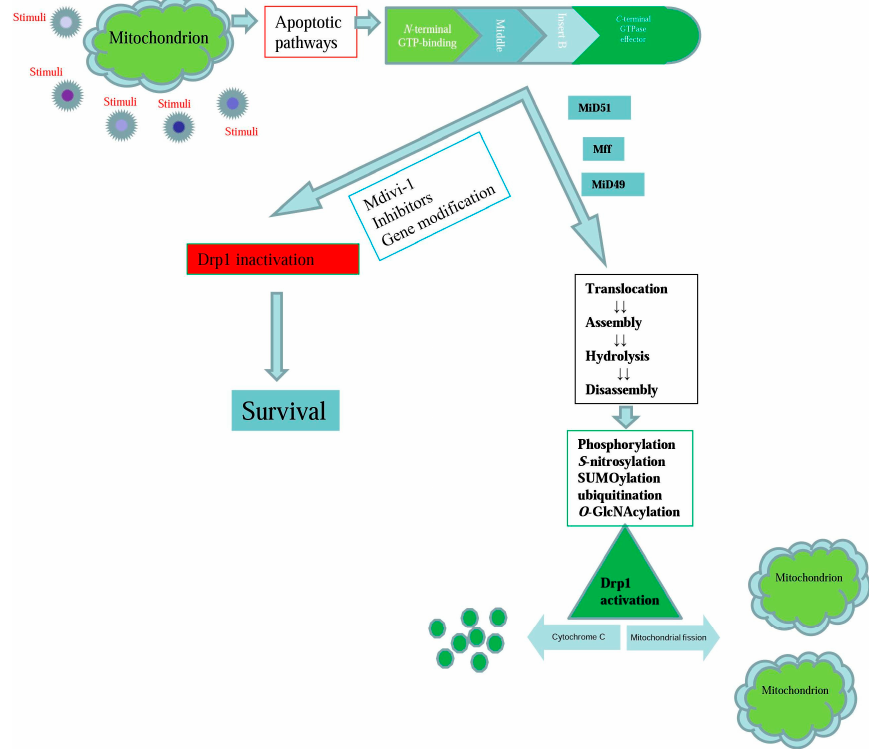
Figure 1. Various stress conditions induce the initiation of apoptotic pathways, mitochondrial fragmentation and concomitant apoptosis. Then Drp1-dependent mitochondrial fission is mediated by translocation of Drp1 to the mitochondrial outer membrane (MOM), subsequent higher-order assembly, GTP hydrolysis, and ultimately disassembly. The effective formation of Drp1 is regulated through post-translational modifications, which results in cytochrome c release and mitochondrial fragmentation. However, interferences inhibit the mitochondrial fission pathway and improve survival rates, even under stressful conditions. Mff, mitochondrial fission factor; MiD51, mitochondrial elongation factor 1; MiD49, mitochondrial elongation factor 2.